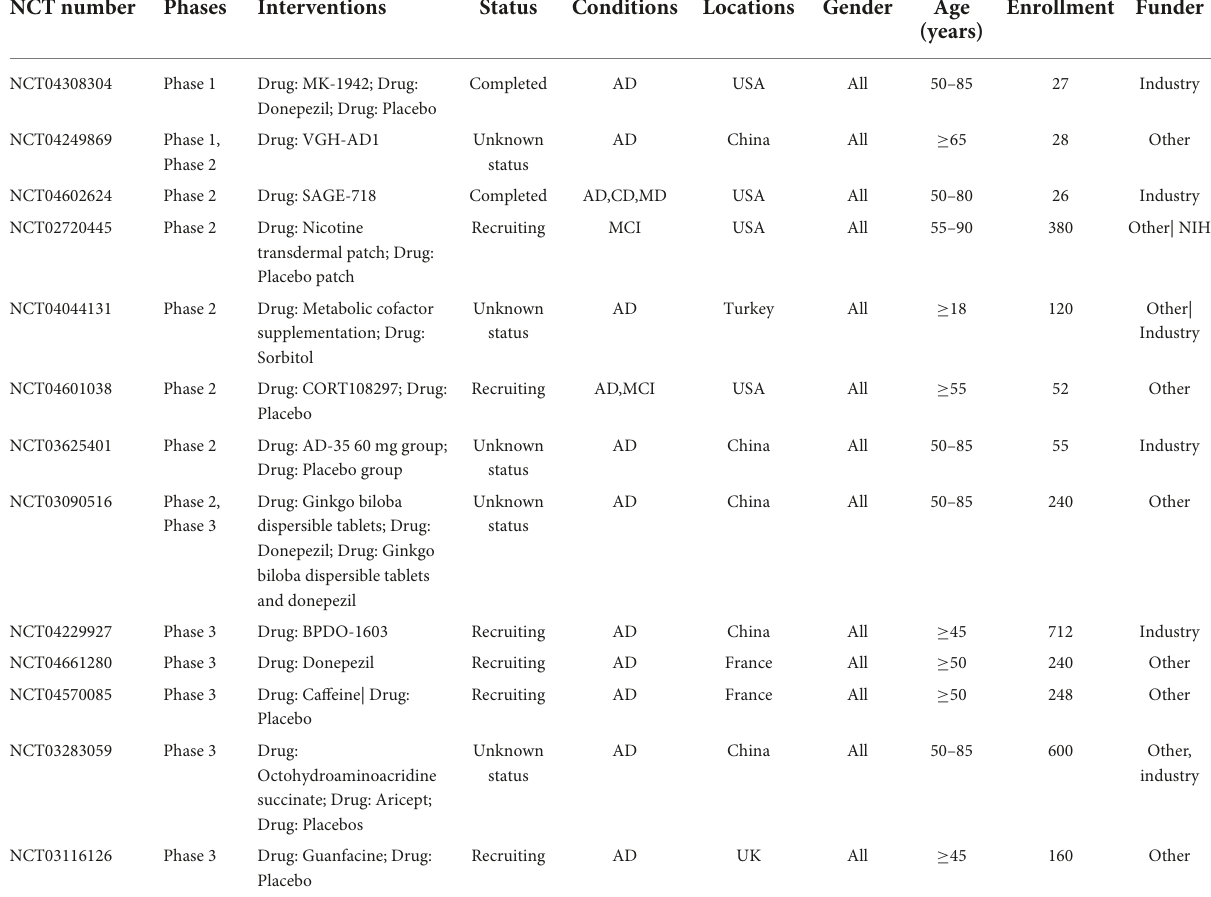
TABLE 2 Clinical trials target cognitive enhancement for Alzheimer’s disease (AD) patients in 2021 in